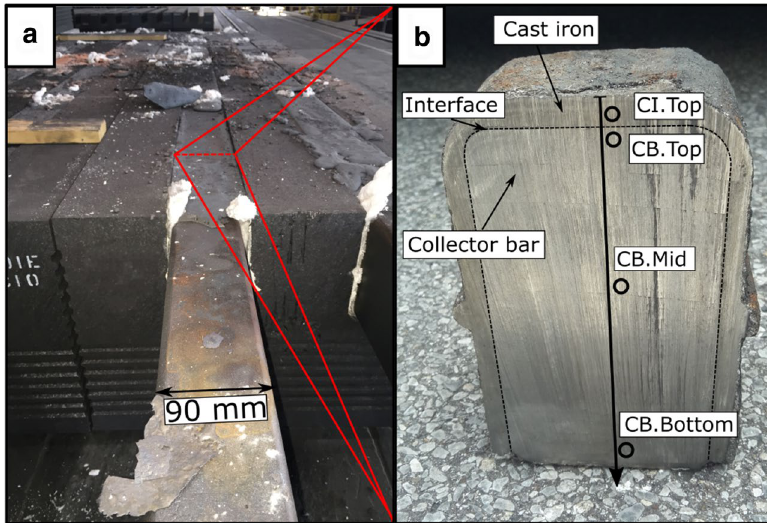
Fig. 3 The collector bar, con- nected with cast iron to the graphite cathode ( a ), and a cross section of a discarded collector bar after use ( b ). Posi- tions from where samples have been taken are